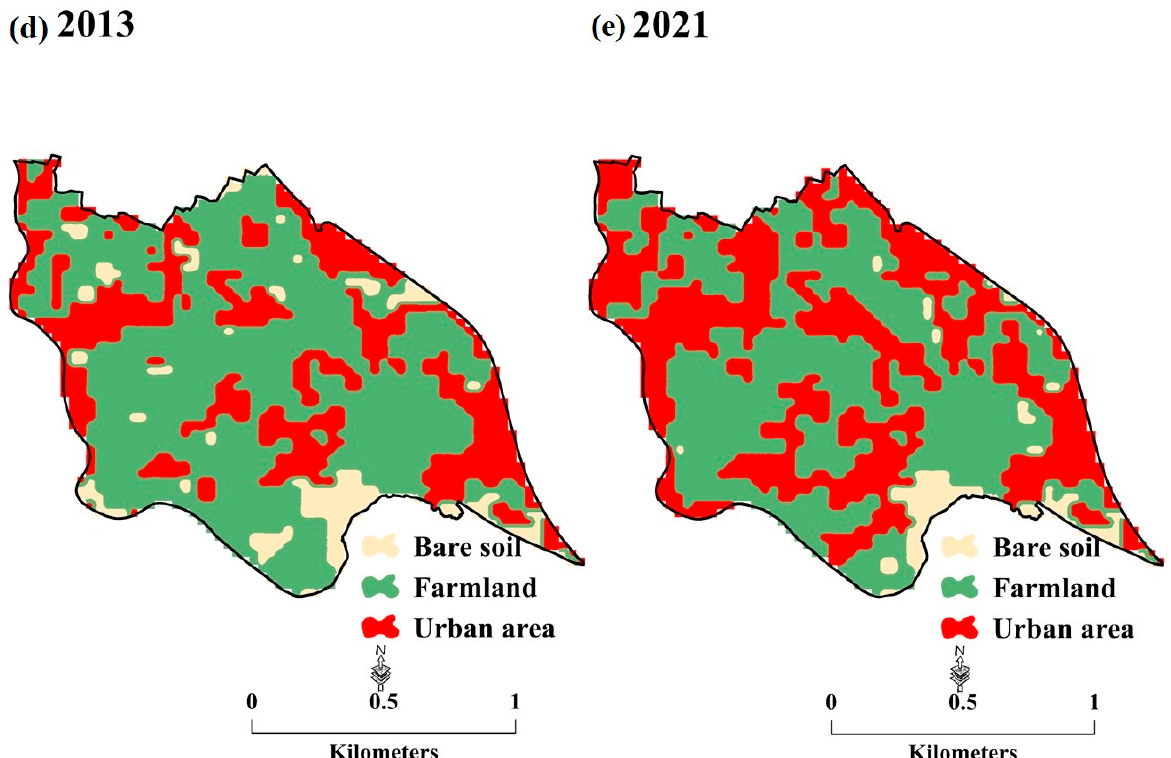
Figure 15. Bare soil (BS), urban area (UA), and farmland (FL) LULC classifications in Falaj Al- Muyasser between 1985–2021.